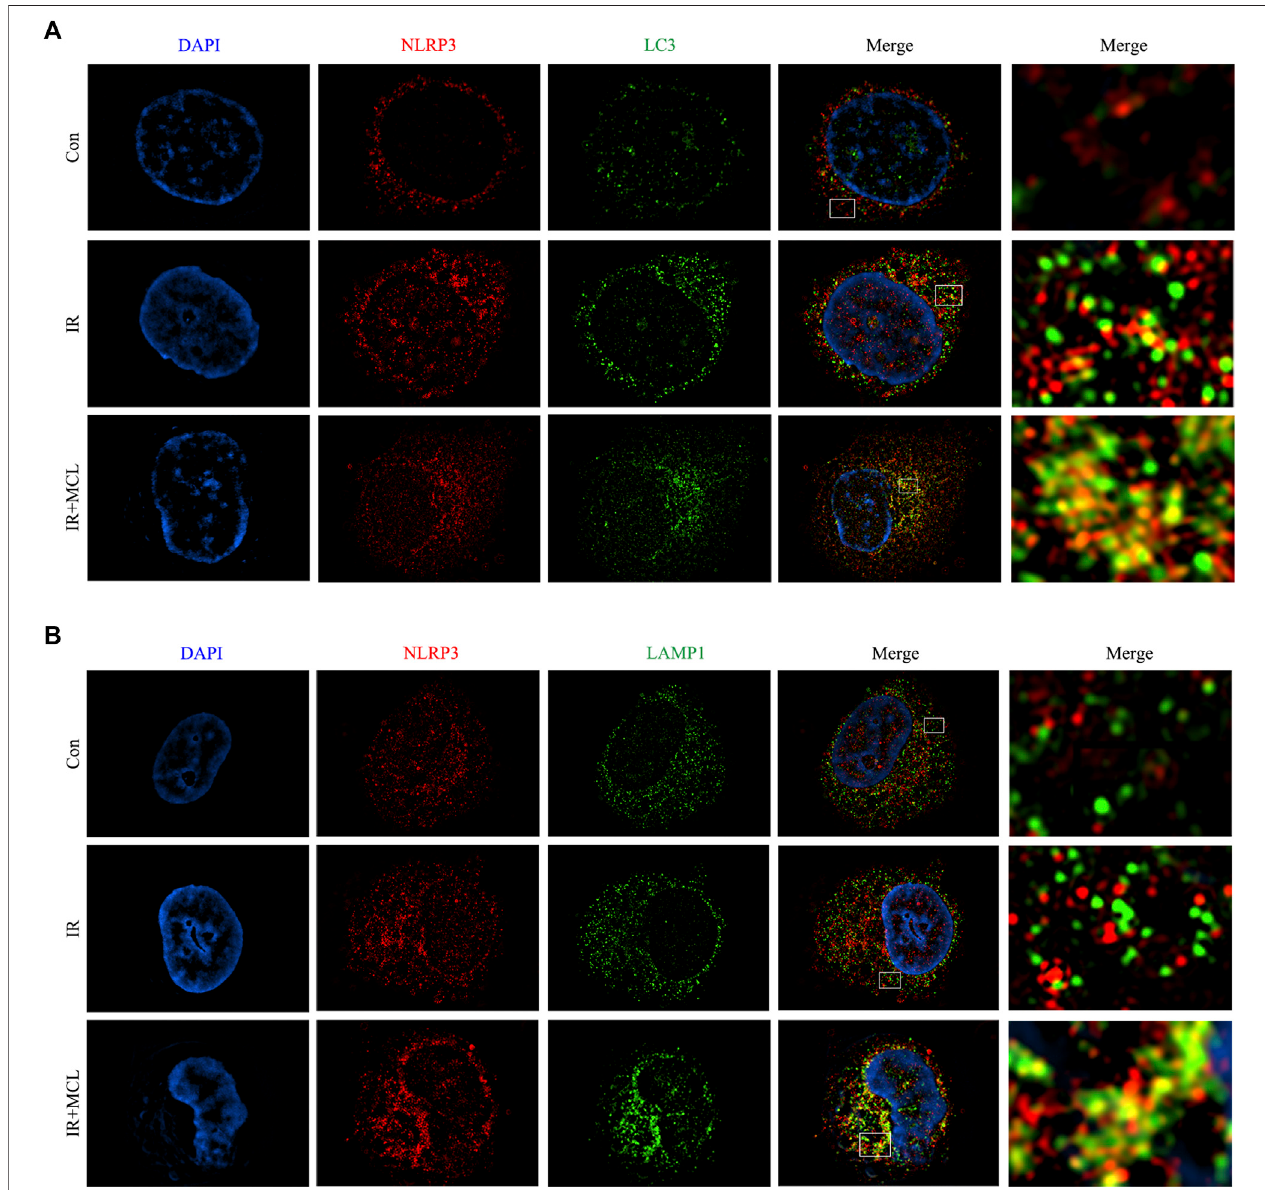
FIGURE6| Micheliolide(MCL)mediatesautophagyoftheNLRP3in fl ammasome (A – B) HIECswerestainedforLC3/LAMP1(green)andNLRP3(red)andanalyzed by confocal microscopy. Co-localization of NLRP3 (arrows) and LC3/LAMP1 (arrowheads) is apparent. * p < 0.05, ** p < 0.01, *** p < 0.001, **** p < 0.0001, two-tailed Student ’ st-test.Con,untreatedHIECs;IR,HIECsexposedtoradiation(10 Gy);IR+MCL,HIECspretreatedwithMCL(10 μ M)priortoradiation(10 Gy)exposure;HIEC, human intestinal epithelial cell; LC3/LAMP1, light chain three/lysosome-associated membrane protein.